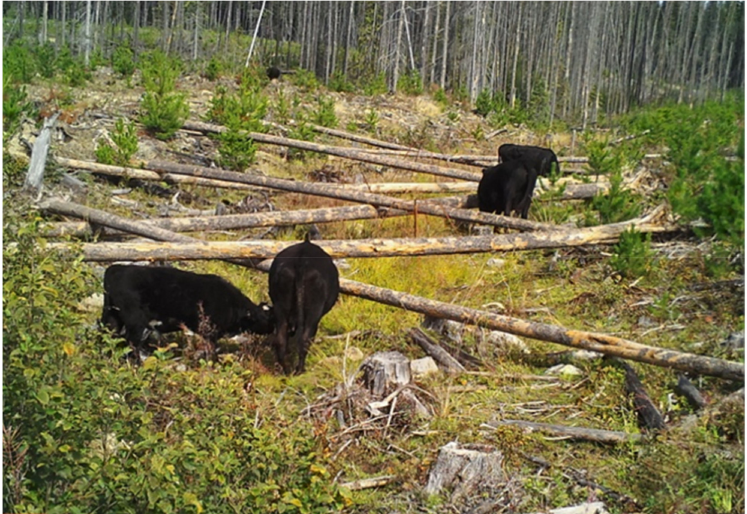
Figure 9. Cattle able to access stream for water but not move up and down channel. (Photo by C.